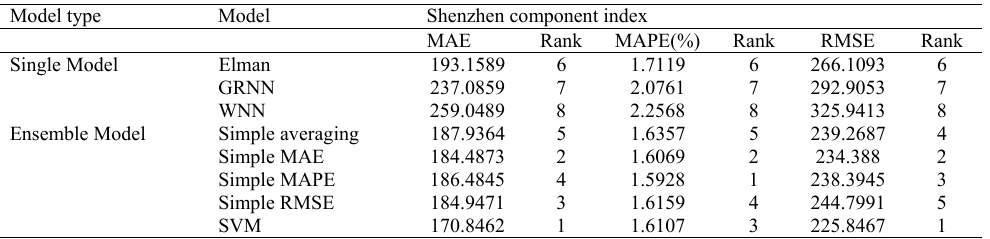
Table 3. Comparison of performance statistics averaging each model over 20 runs in Shenzhen component